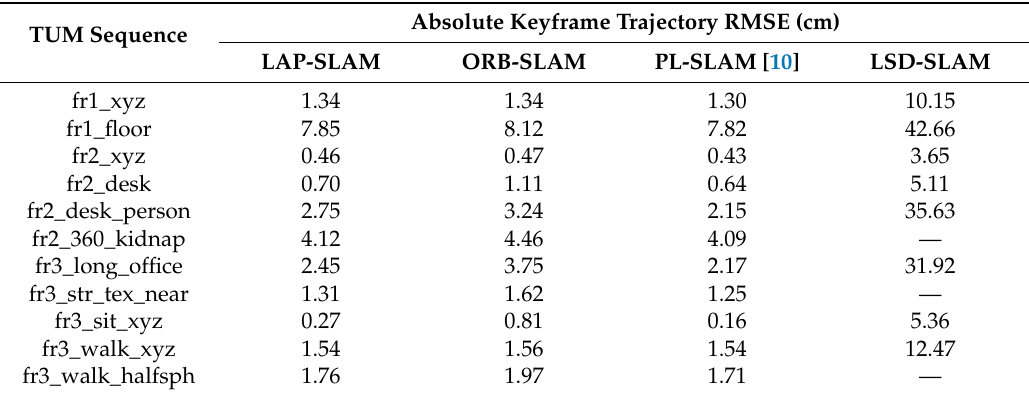
Table 4. Localization accuracy in the TUM RGB-D benchmark.